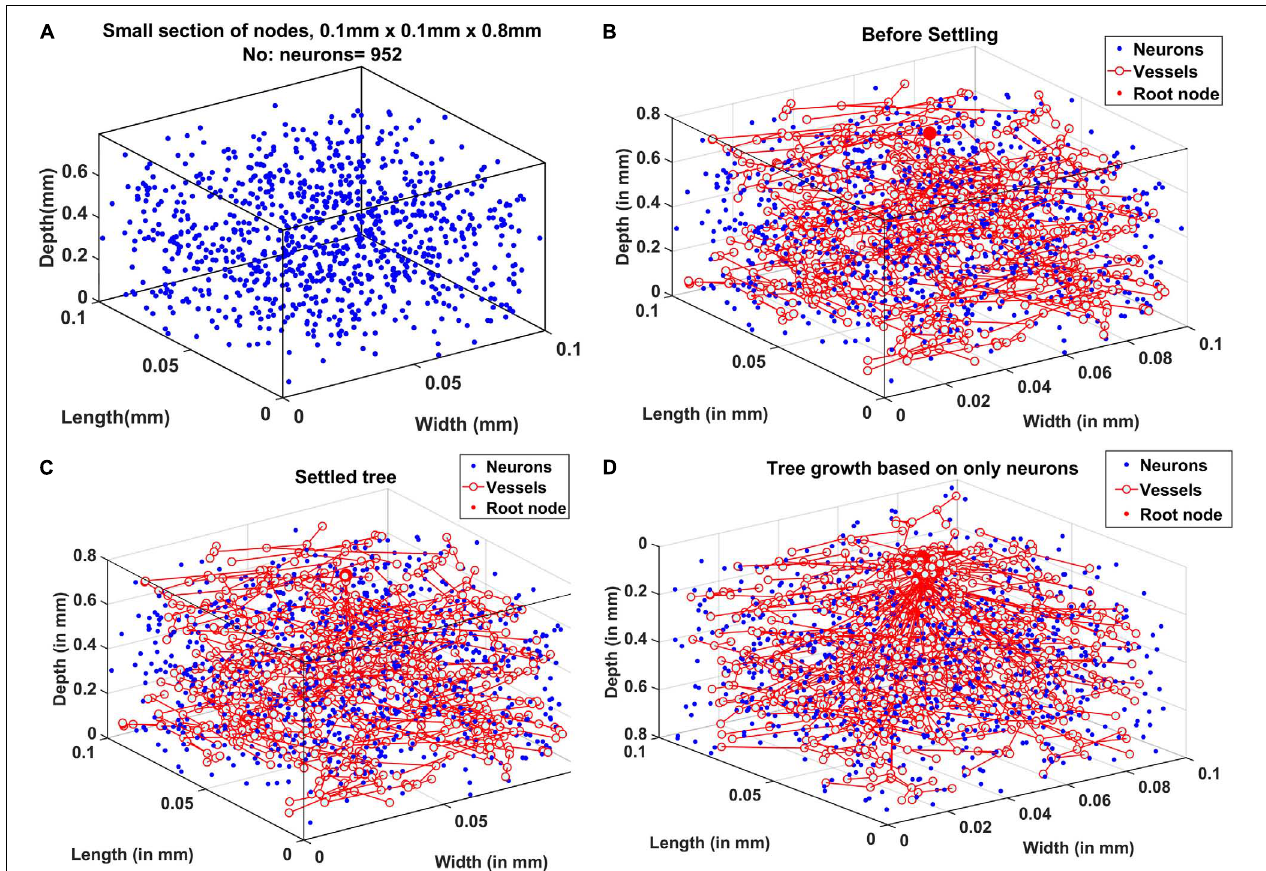
FIGURE 5 | (A) Neural distribution in the slab of tissue under observation, (B) tree formed after the growth phase (grown under the influence of all cortical cells), (C) tree formed after the settling phase (grown under the influence of all cortical cells), and (D) tree grown and settled under the influence of only neurons.